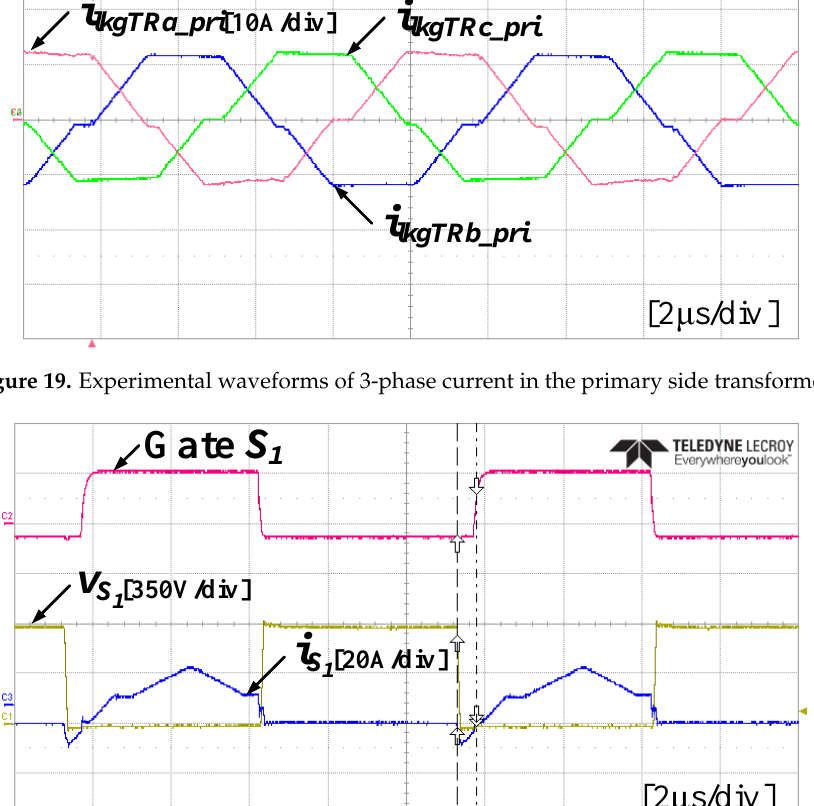
Figure 19. Experimental waveforms of 3-phase current in the primary side transformer.